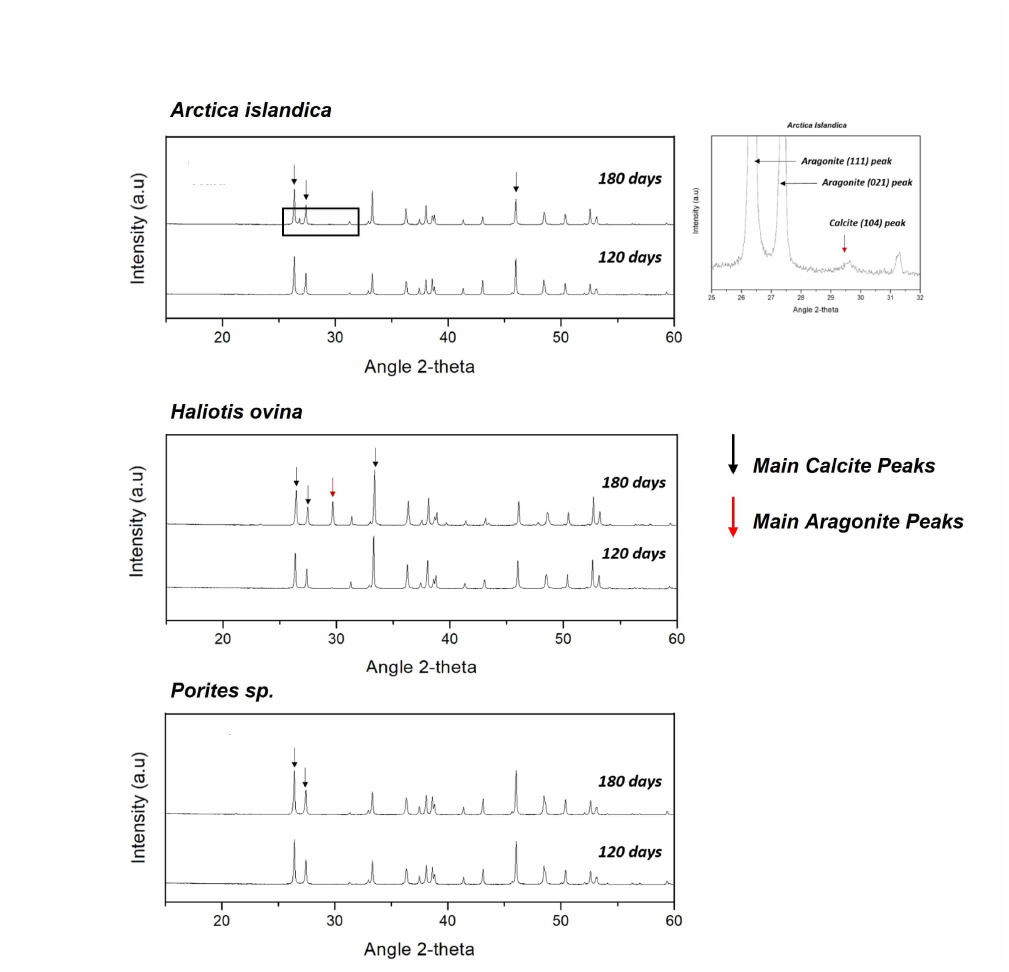
Figure A2. X-ray diffractograms of the hydrothermally altered shells and skeletons of Arctica islandica , Haliotis ovina and Porites sp. Alteration was performed at 80 ◦ C in a Mg-rich, burial-mimicking fluid (100mM NaCl + 10mM MgCl 2 ) and lasted for 4 and 6